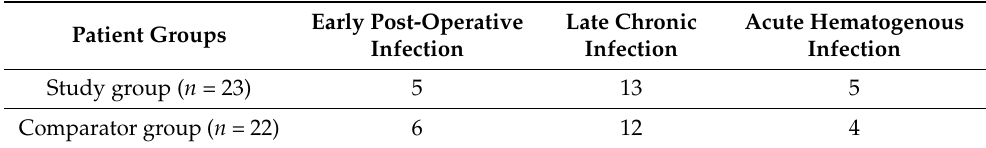
Table 1. Patient distribution based on type and time of PJI manifestation according to classification of Tsukayama et al. [34] in both groups (ITT population).